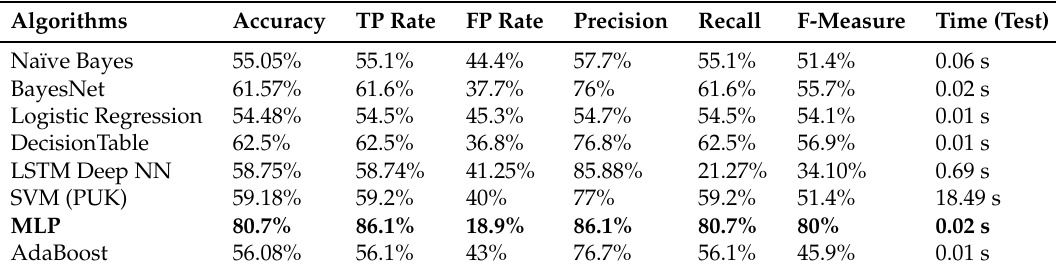
Table 7. Performance evaluation for attack scenario 4.